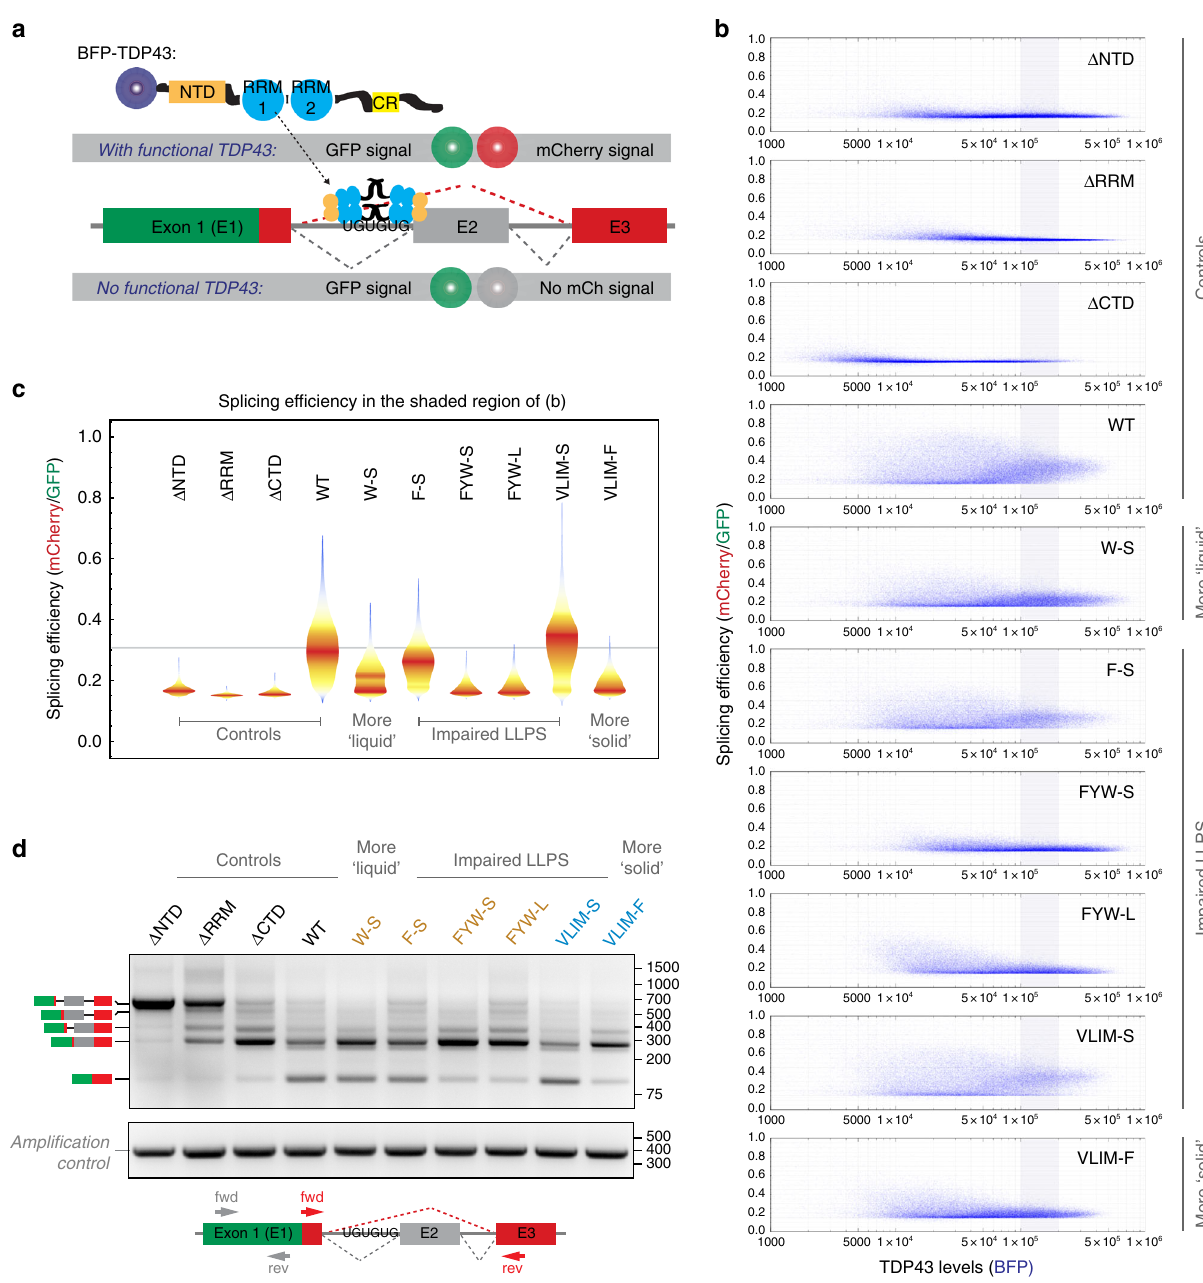
Fig. 7 LLPS-de fi cient TDP43 supports exon skipping in a single-cell splicing reporter. a Splicing reporter design. Production of a dually- fl uorescent GFP- mCherry fusion protein depends on the presence of functional full-length TDP43 to mediate skipping of exon 2 ( “ E2 ” , derived from the TDP43-regulated exon 9 of the CFTR gene). TDP43 and its CTD variants contain N-terminal BFP tags. BFP-TDP43 and the GFP-mCherry splicing reporter are expressed from the same plasmid via a bidirectional promoter by transient transfection in TDP43 − / − HEK-293T cells. b Splicing ef fi ciency of the indicated TDP43 compositional mutants quantitatively measured on a single-cell level by fl ow cytometry. Splicing ef fi ciency is expressed as the mCherry/GFP ratio per cell and plotted against TDP43 abundance, measured by BFP fl uorescence. c Splicing ef fi ciency of the indicated TDP43 mutants in cells selected to have similar expression levels (derived from the region highlighted in b by blue shading). Data are presented as violin plots, with color-coding representing the probability density of cells with a particular mCherry/GFP ratio. The gray horizontal line indicates the median mCherry/GFP ratio for WT TDP43. d Exon- skipping activity of TDP43 variants measured by RT-PCR using primers spanning exon 2 (see cartoon below the gels). Diagrams to the left denote the electrophoretic positions of the various splicing intermediates and products. GAPDH was used as ampli fi cation control